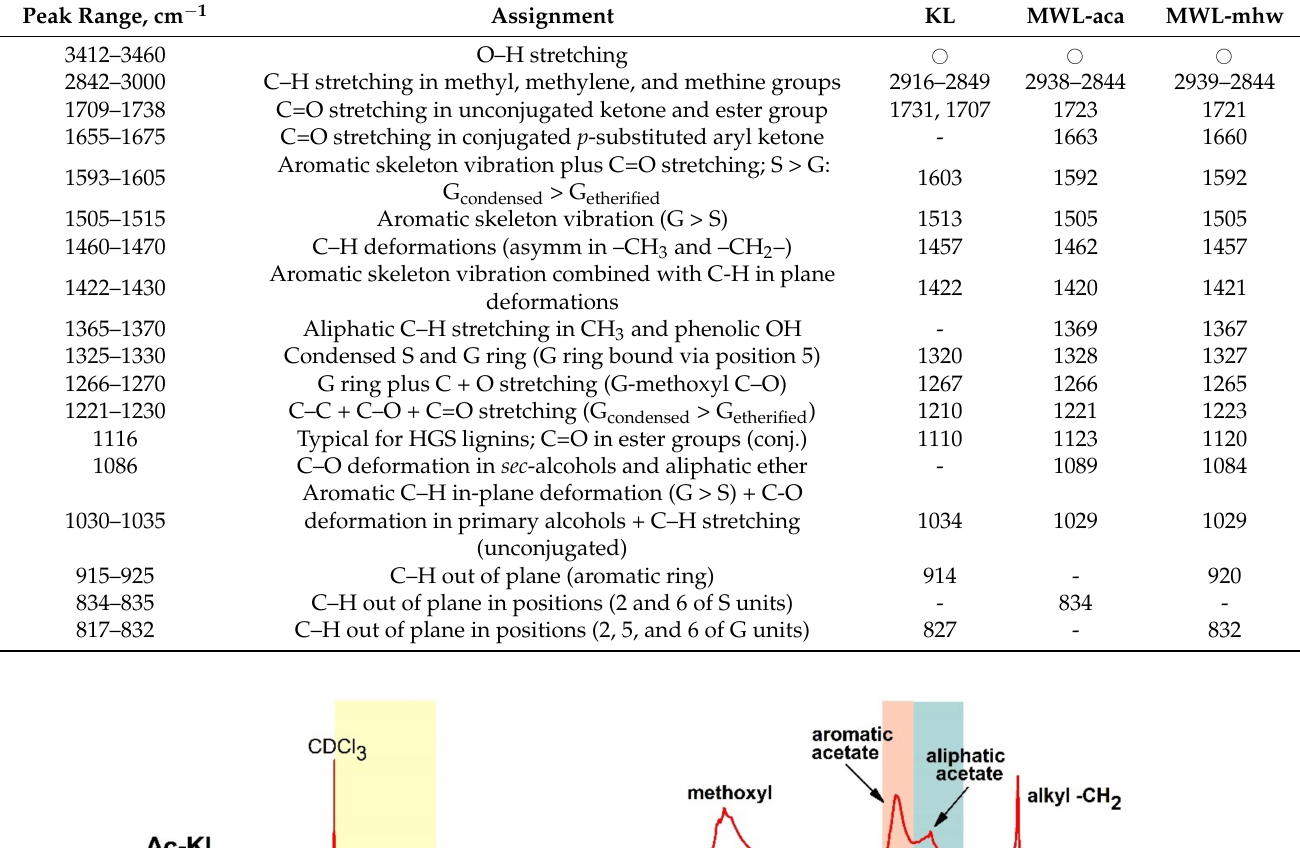
Table 5. Assignment of FT-IR spectra of KL and MWLs.